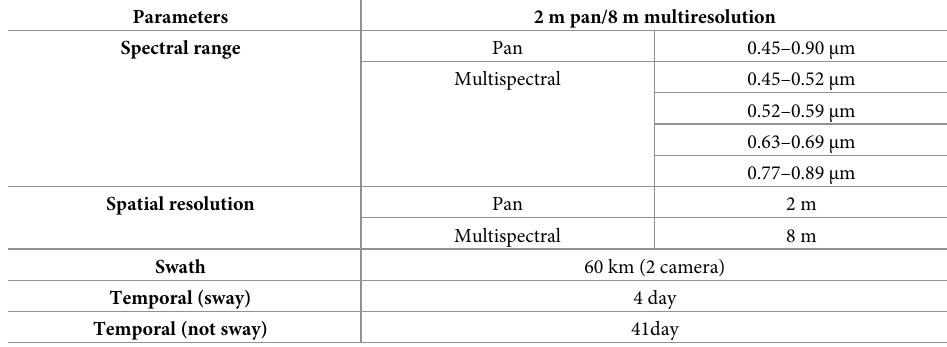
Table 1. GF-1 satellite PMS data